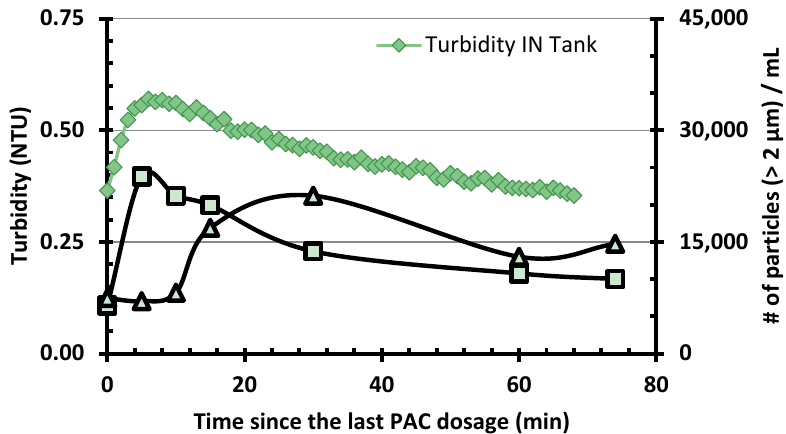
Figure 3. Particle counts and turbidity measured during the PAC export assay. Samples were collected before/after the transfer tank supplying the membranes (see Figure 1).